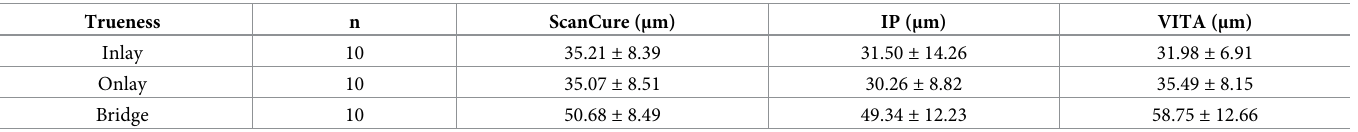
Table 2. The RMS values of three experimental groups (ScanCure, IP, VITA) in each reference model (mean ± SD). Trueness n